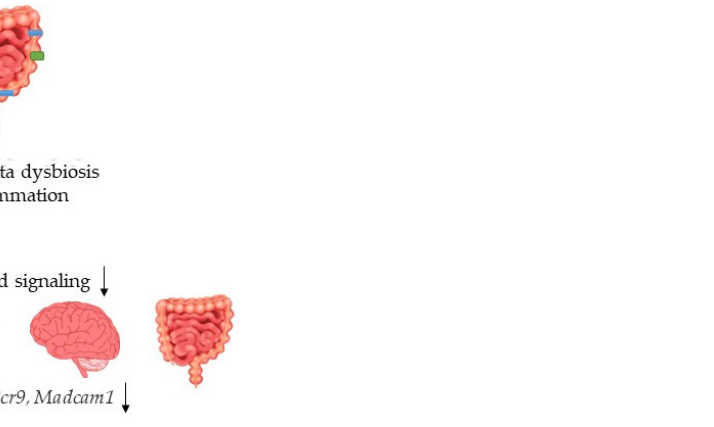
Figure 8. DSS-induced gut dysbiosis and colitis cause compromised retinoic acid signaling at the systemic level. Downward arrows next to signaling or gene names indicate inhibition.